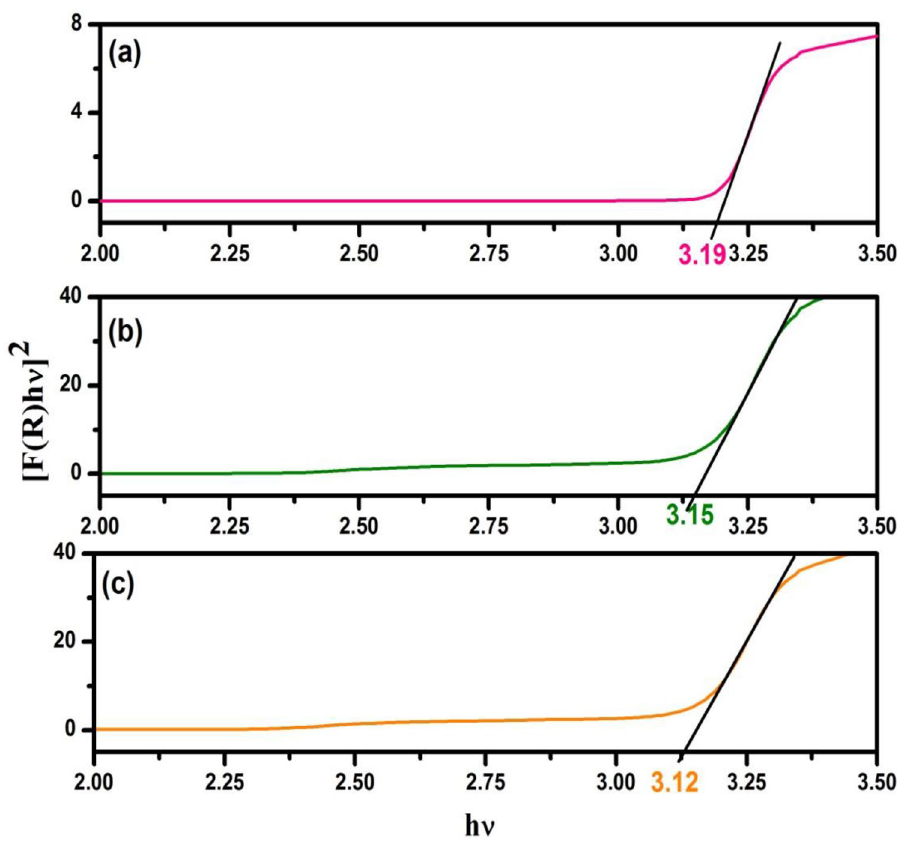
Figure 6. Direct band gap of the ( a ) CT ( b ) CS-CT and ( c ) AS-CT